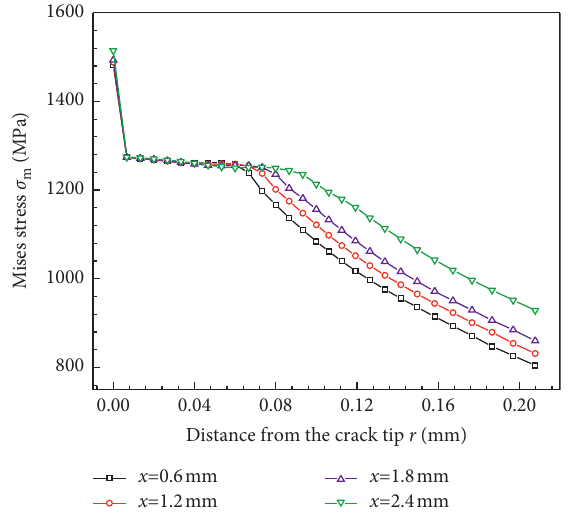
Figure 14: Mises stress curves at the front of FB line crack